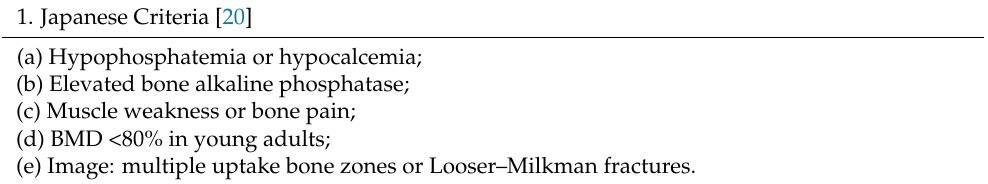
Table 1. Clinical criteria for